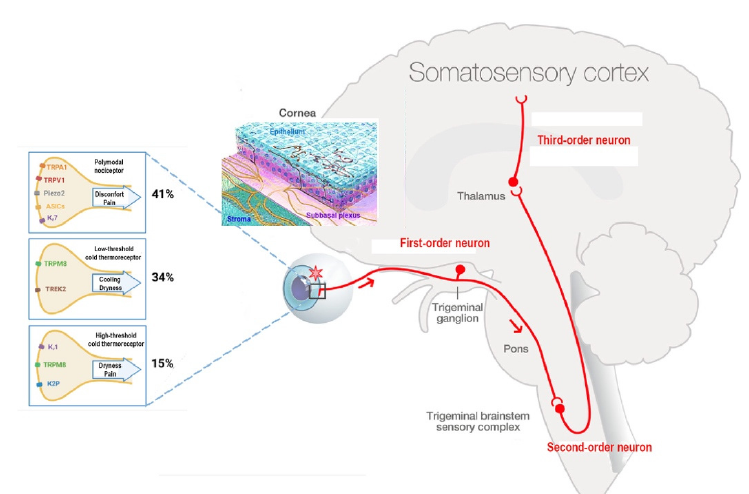
Figure 1. The ocular sensory pathway. “Adapted with the permission from [34] copyright 2022 Elsevier, Melik Parsadaniantz”, first-order neuron: corneal nerve endings present their cell body in the TG and synapse at TBSC levels (red). Second-order neuron connects to contralateral pathways and synapse in the thalamus. At the end, third-order neuron transfers the information to paralimbic region and somatosensory cortex. Corneal epithelium nerve terminals. Corneal nociceptors and cold thermoreceptor and their transducing channels. Percent of corneal mice nociceptors and cold thermoreceptors. Image Adapted with the permission from [32] copyright 2022 IOVS, Melik Parsadaniantz”. Finally, the firing activity of mechano-nociceptors (which are expressed in A δ nerve fibers and represent 10% of total nociceptors) increases only secondary to mechanical forces but remains silent in the absence of stimulation [26,35]. Furthermore, the activation of corneal mechanonociceptors results in instant and severe sensation of pain [9]. 3. The TRP Channels and Their Implication in the Physiology and Pathophysiology of the Anterior Segment of the Eye In 1969, the first transient receptor potential (TRP) channel was discovered in a mu- tant strain of Drosophila melanogaster . Deficiency of the TRP gene resulted in damage to the Drosophila’s visual system [36]. Later, in 1992, Roger Hardie and Baruch Minke showed that the TRP gene is crucial for a light-activated Ca 2+ channel in the fly’s photoreceptors [37]. Initially, TRP represented a light-sensitive channel, and this was supported by the cloning of the second light-sensitive channel, TRPL. Then it was shown that TRPL plays a crucial role in maintaining a sustained response during prolonged illuminations [38]. Since then, different TRP homologues have been identified. TRP channels function as nonselective cation-permeable channels and, when acti- vated, depolarize the cell, leading to subsequent voltage-dependent ion channel activation and changes in intracellular Ca 2+ concentrations. Thus, this may explain the implication of TRP mutations in diverse diseases, such as neurodegenerative diseases, skeletal dysplasia, kidney diseases, and pain [39,40]. TRP channels are composed of six transmembrane domains with four subunits sur- rounding a centrally located ion permeation pore with intracellular N and C terminals. Their classification is based on sequence similarities and not on their common functional features. Regarding this classification, members of the same family may be functionally